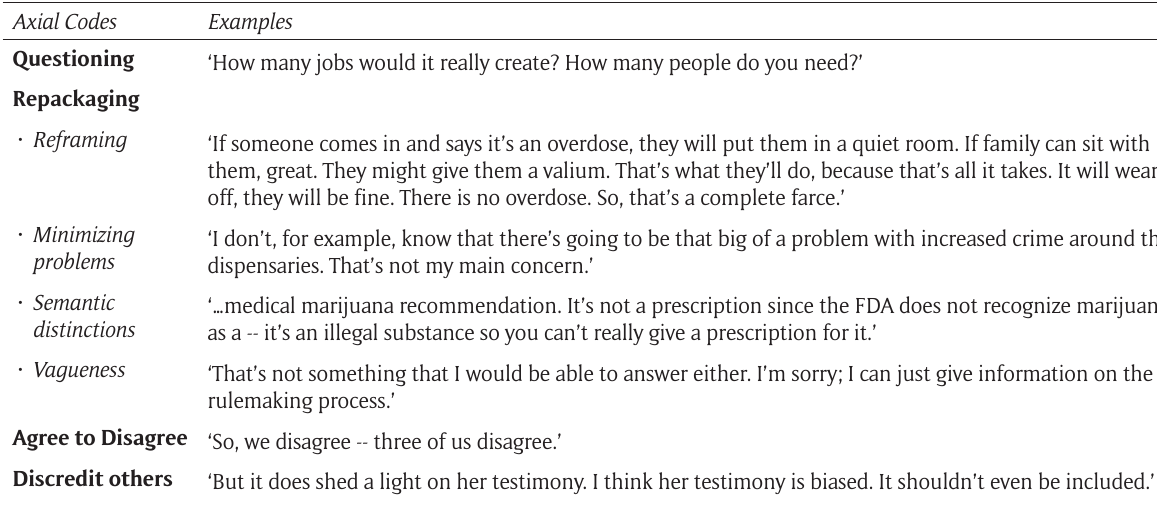
Table 2: Expressing Disagreement. Disagreement (RQ2) Axial Codes Examples